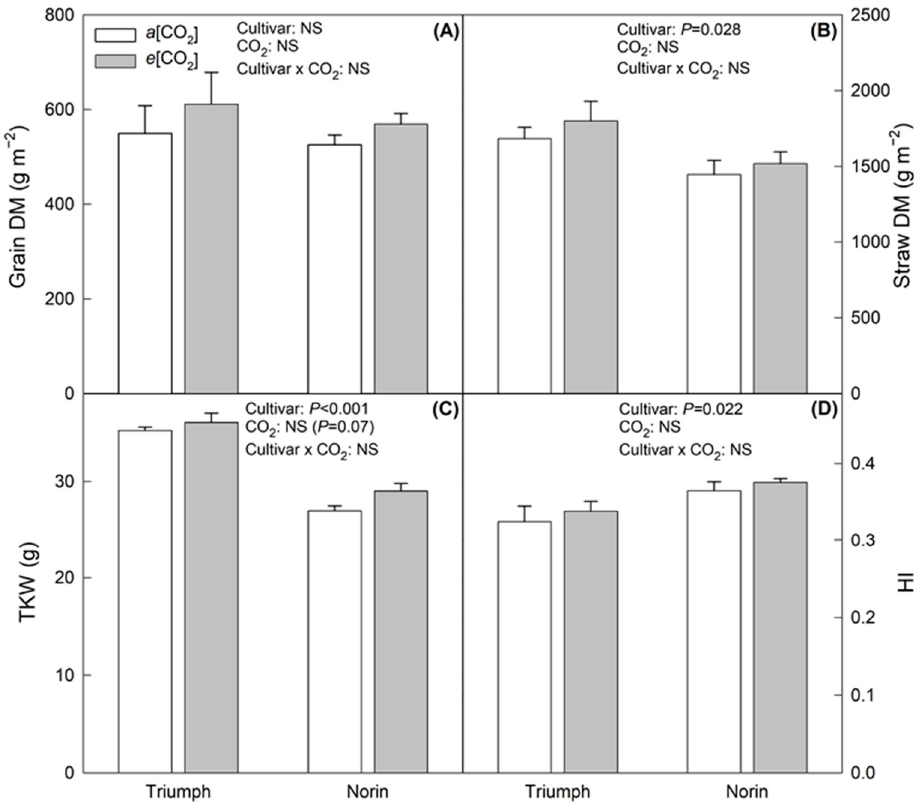
Figure 1. Agronomic responses to e [CO 2 ] in both cultivars evaluated (Triumph and Norin). ( A ) Grain DM; ( B ) Straw DM; ( C ) TKW; and ( D ) HI. Each bar indicates standard error of means ( n = 3)